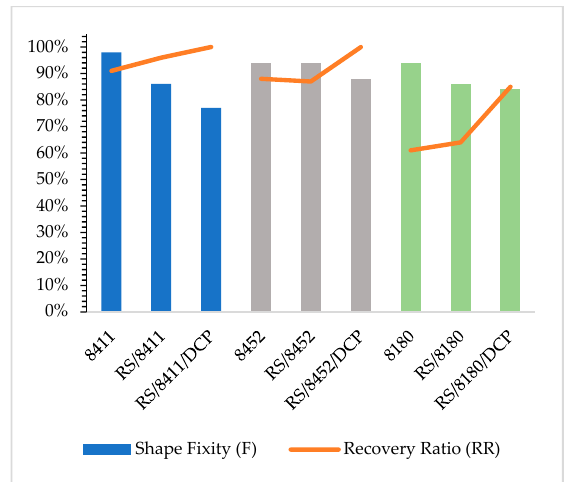
Figure 11. The shape fixity F factor and the recovery ratio RR parameter for neat thermoplastic elastomers Engage 8411, 8452, 8180, RS/TPE and RS/TPE/DCP blends.